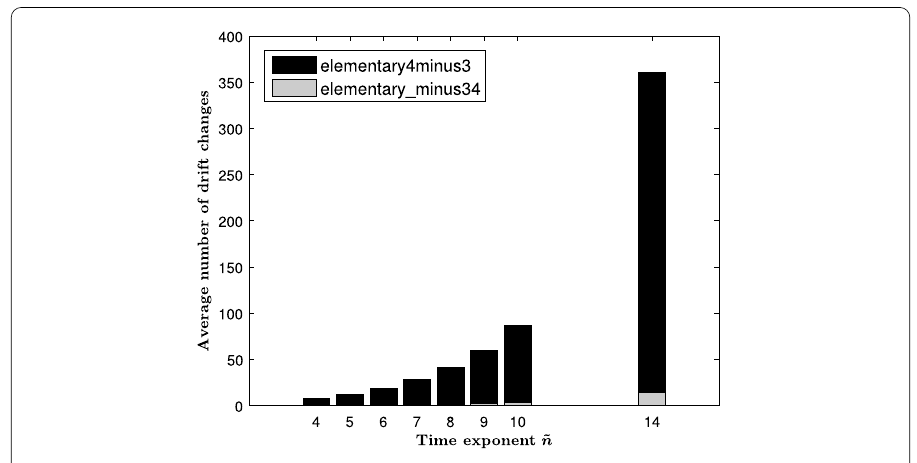
Figure 1 Average number of drift changes for ξ = 1.4: elementary4minus3 vs. elementary_minus34